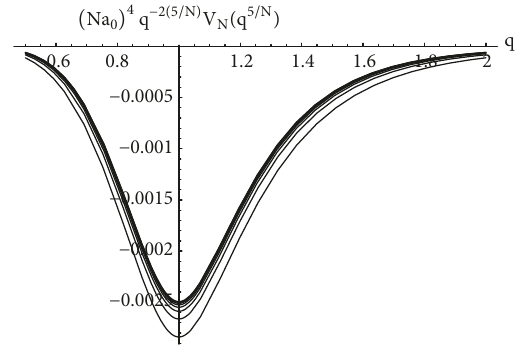
Figure 5: The numerical results for (𝑁𝑎 0 ) 4 𝑞 −2(5/푁) 𝑉 푁 (𝑞 5/푁 ) as func- tions of 𝑞 for 𝑁 = 3,4, .. ., 10 , from lower to upper